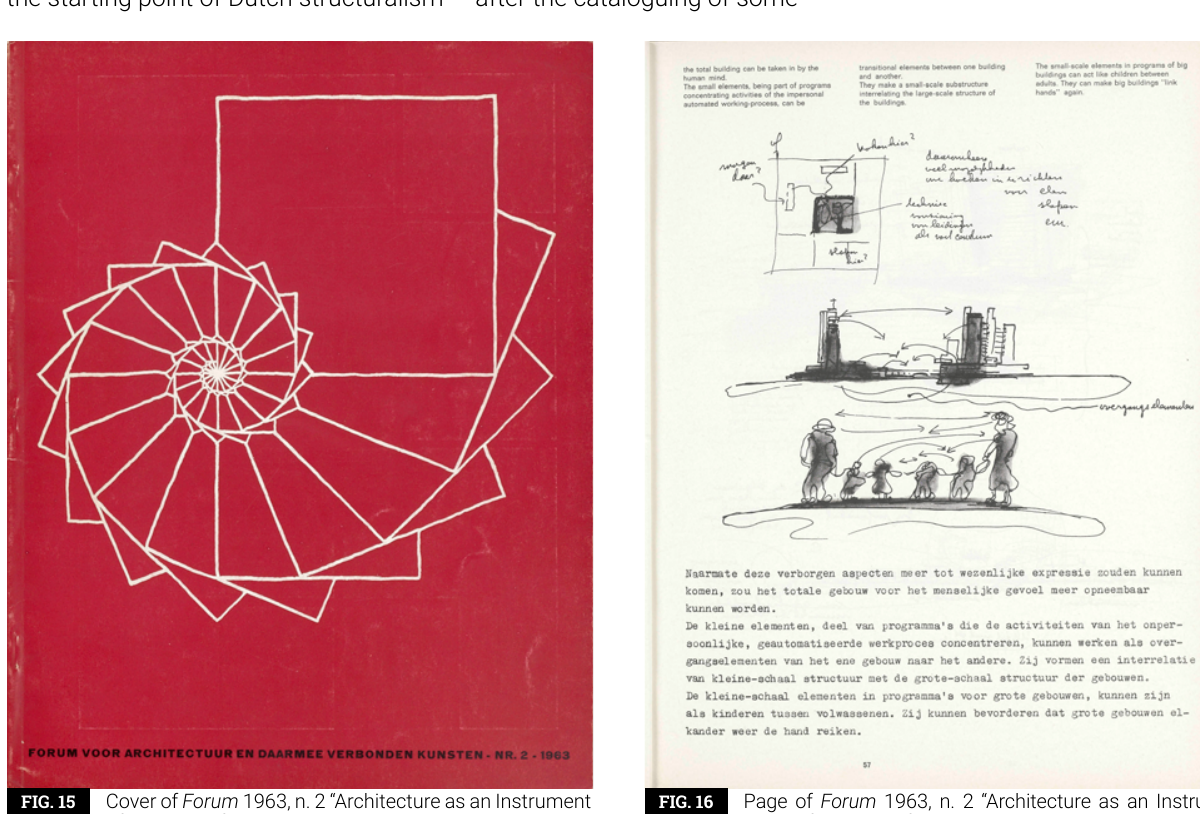
Daarmee Verbonden Kunsten 17, n. 2 (1963).